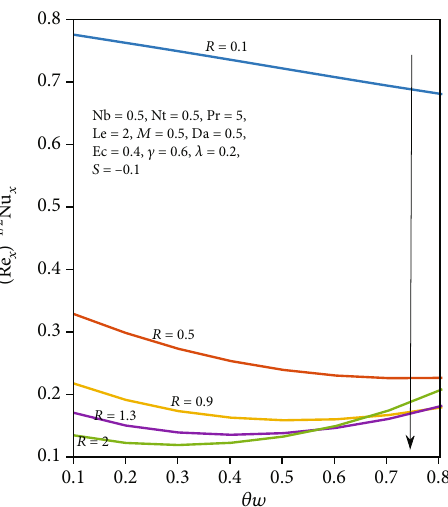
Figure 23: Skin friction pro fi le for di ff erent values of M , Da .